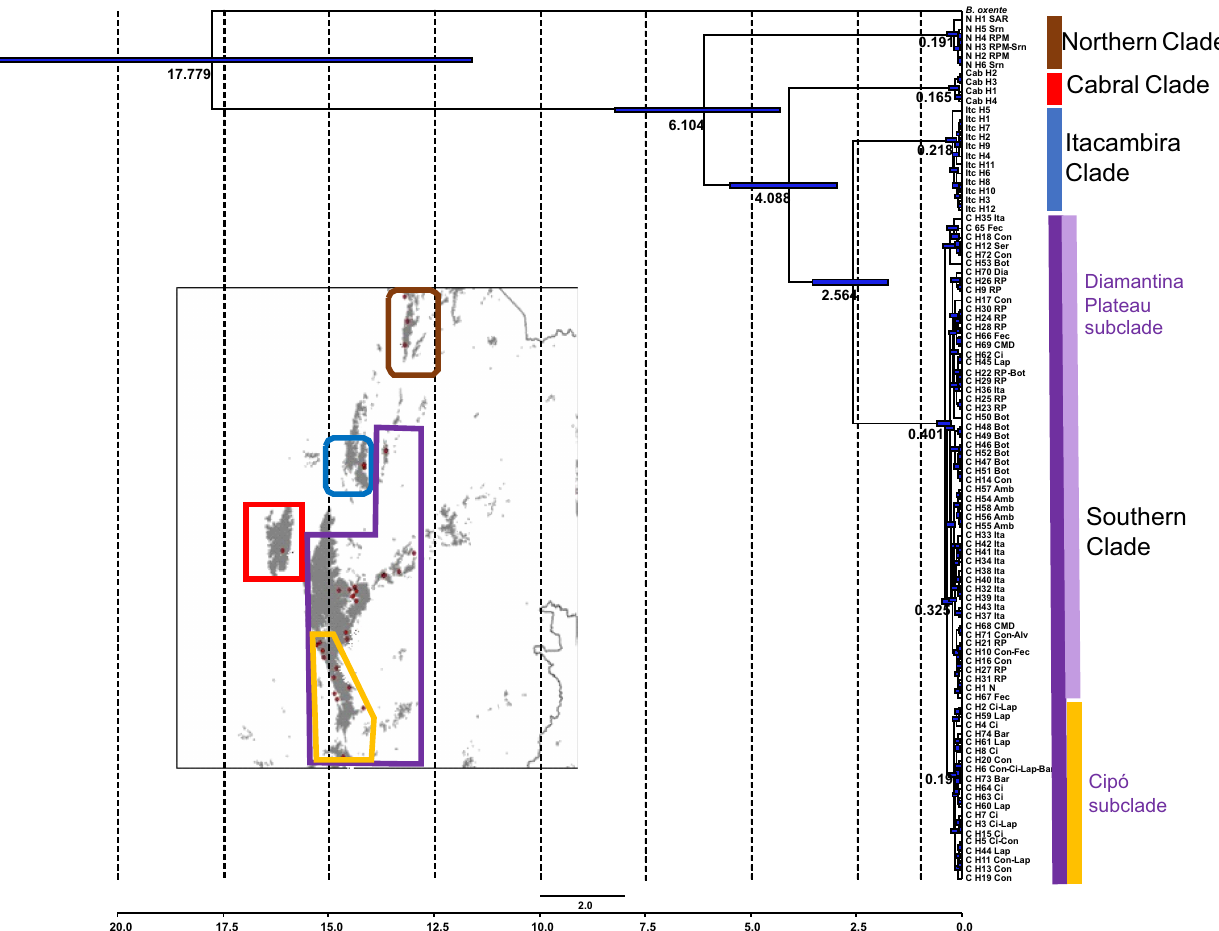
Fig 2. Divergence times and phylogenetic relationships within B . saxicola . Bayesian Tree with divergence times and phylogenetic relationships within B . saxicola complex haplotypes. The blue bars represent the divergence time with the 95% HPD confidence interval. The map indicates the four main clades, and the two subclades.